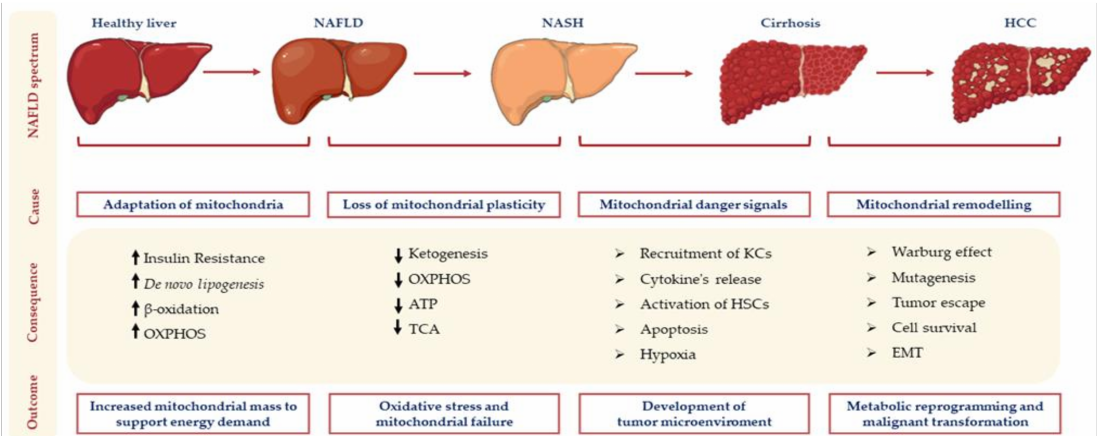
Figure 1. The prominent role of mitochondria in nonalcoholic fatty liver disease (NAFLD)/nonalcoholic steatohepatitis (NASH)- related hepatocellular carcinoma (HCC). Sedentary lifestyle coupled to hypercaloric diet and genetic background lead to the development of insulin resistance (IR), which causes NAFLD onset. In addition, compensatory hyperinsulinemia activates de novo lipogenesis (DNL) and exacerbates hepatocytic fat accumulation. From the early stages of NAFLD, mitochondria adapt in number and function in response to lipid overload, increasing β -oxidation, oxidative phosphorylation (OXPHOS) capacity and biomass (mitochondrial adaptability). Nevertheless, mitochondrial flexibility is compromised during fatty liver progression towards NASH, resulting in blunted ketogenesis, tricarboxylic acid cycle (TCA), OXPHOS and adenosine triphosphate (ATP) production. Consequently, mitochondrial oxidative stress and the release of mitochondrial danger signals worsen inflammation by recruiting and activating Kupffer cells (KCs) alongside fibrogenesis through hepatic stellate cells (HSCs) activation. The inflammatory response together with enhancing apoptosis and hypoxia contribute to generating the surrounding microenvironment that influences malignant transformation and tumor escaping mechanisms. Thus, the loss of mitochondrial dynamics, the accumulation of damaged mitochondria and the remodeling of mitochondrial activities may lead to metabolic reprogramming of hepatocytes, characterized by the switch towards the Warburg effect, mutagenesis, epithelial–mesenchymal transition (EMT) and several strategies of tumor escape from apoptosis in order to promote the compensatory proliferation and HCC